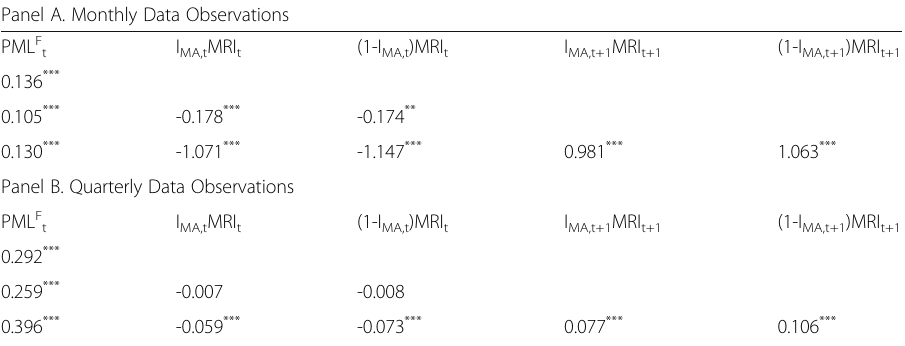
Table 14 Regression with Mean Reversion Indicator and Good Time Indicator Controlled Panel A. Monthly Data Observations